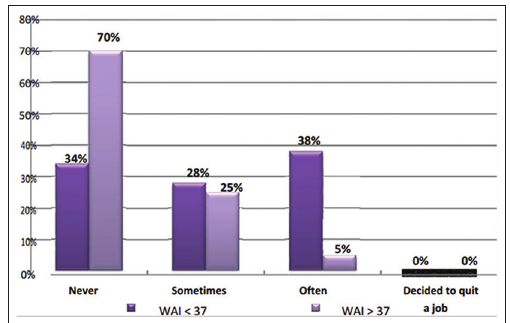
FIGURE 8. Work ability and employees’ interest in a job. Seventy percent of the employees with good work ability stated that they have never wished to quit a job, while 27 (38%) employees with bad work ability reported that they often think about quitting the